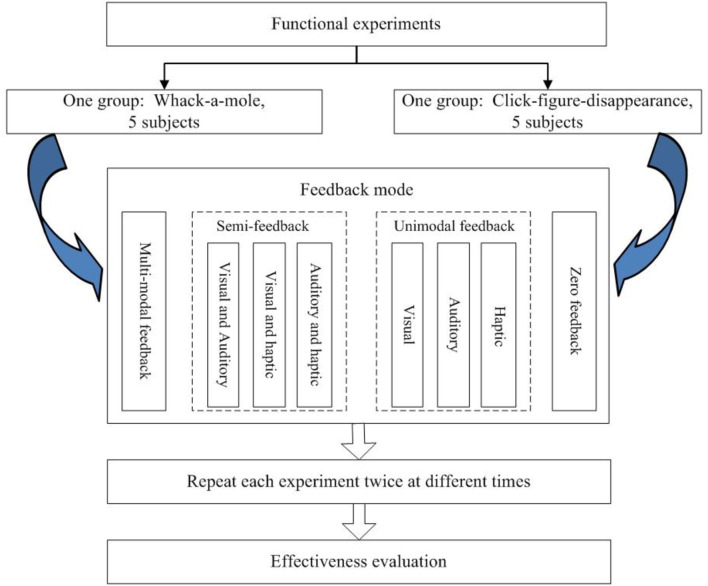
Experiment planning.